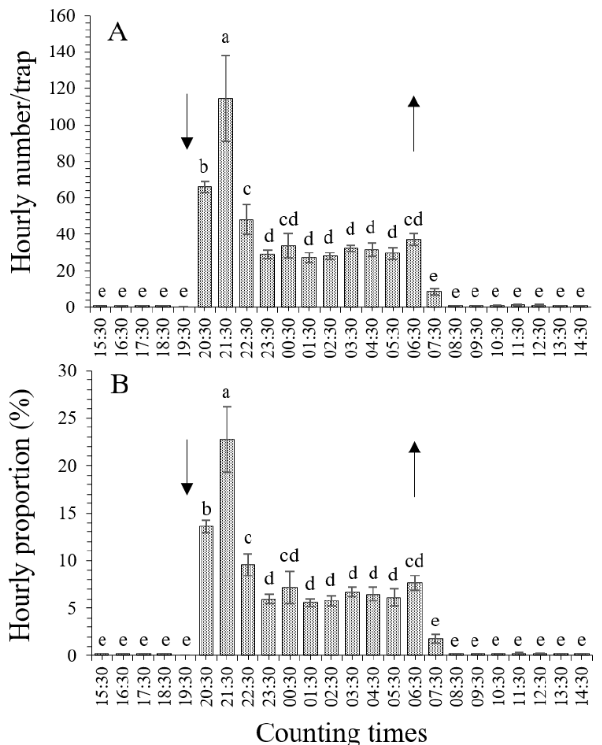
Figure 2. Hourly distribution of total Tuta absoluta adults flying toward UV light traps. Different lowercase letters indicate significant differences among different hourly periods at the p < 0.05 significance level (one-way ANOVA and LSD test). The up and down arrows indicate sunrise and sunset, respectively. ( A ), hourly distribution of numbers; ( B) , hourly distribution of proportions.